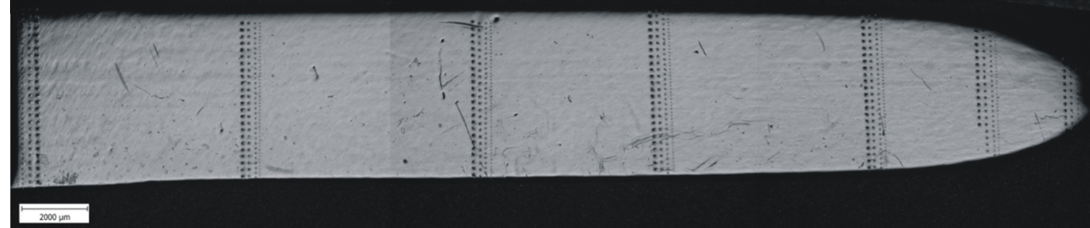
Figure 2. The sample of the tensile piece for the measurement of micro-hardness.